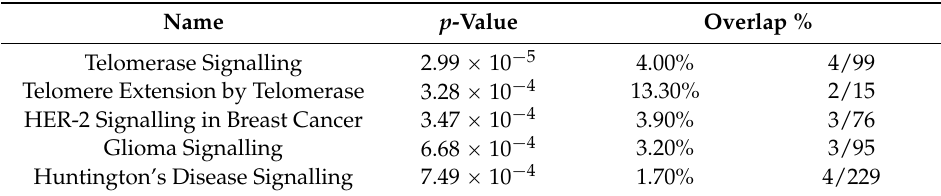
Table 2. Top Canonical Pathways for LAP1 interactors dataset.